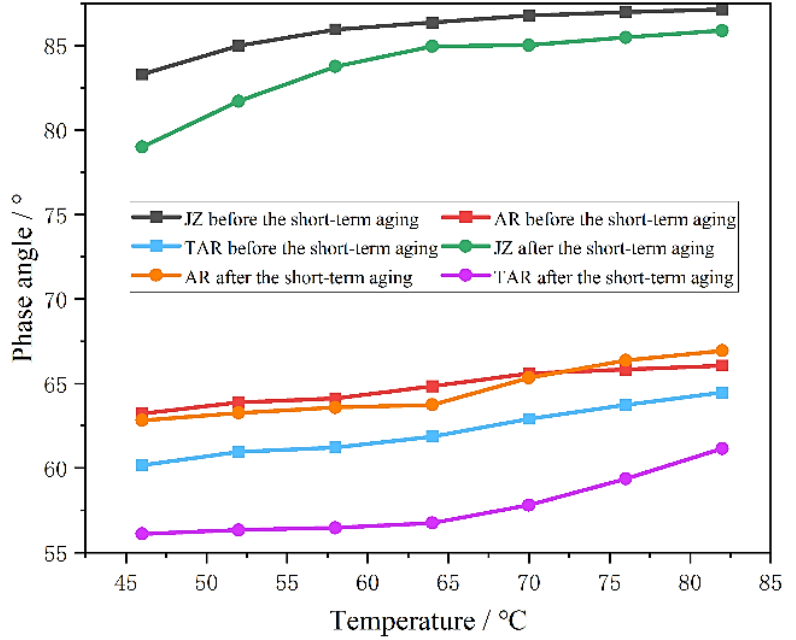
Figure 14. Phase angle.